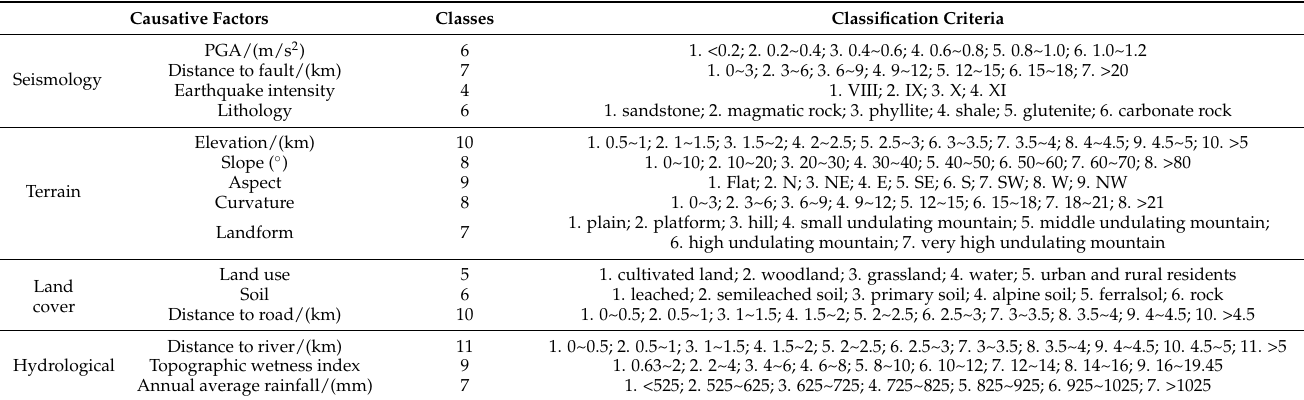
Table 2. Causative factors categories of landslide.